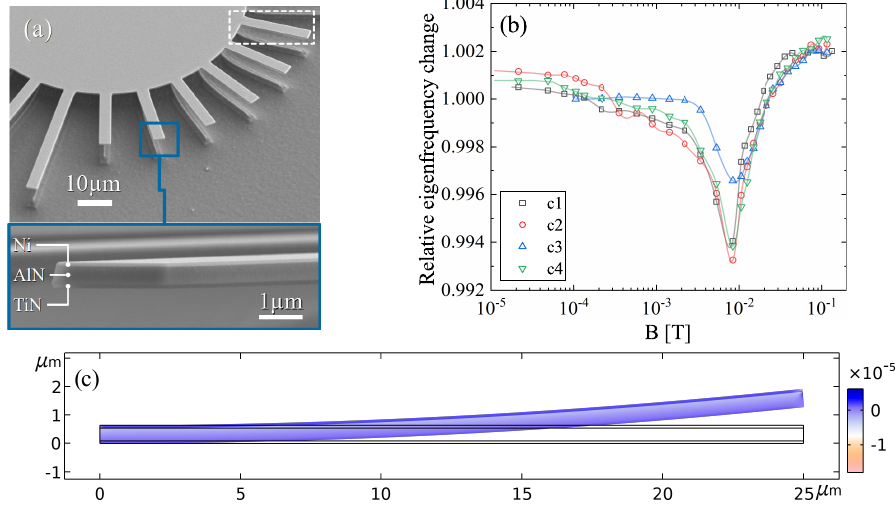
Figure 1. ( a ) SEM images of 4µm wide magnetoelectric cantilevers consisting of a TiN(90nm)/ AlN(450nm)/Ni(100nm) layer stack investigated in recent work [26]. ( b ) Eigenfrequency character- istics in dependency of the magnetic flux of four 25µm long and identically aligned cantilevers as marked in ( a ). ( c ) Solution of the 2D model used for the simulation study with the layer configuration from ( a ). The bending effect due to magnetostrictive strains in the 25µm cantilever is upscaled for better